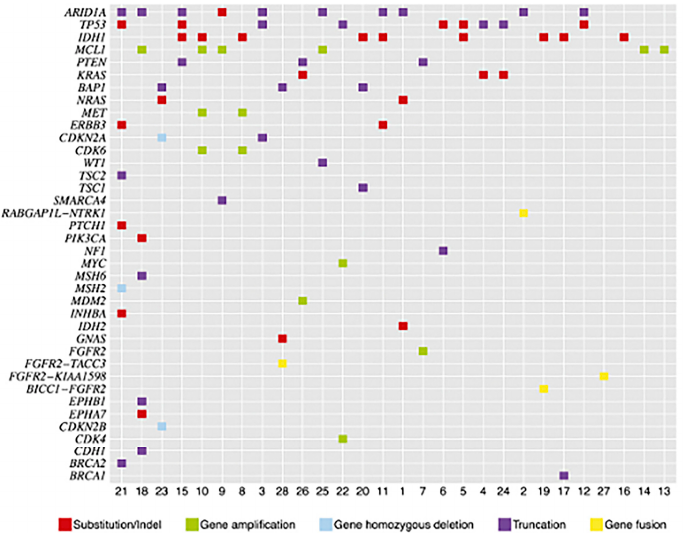
Figure 2. Tile plot of genomic alterations in 28 cases of ICC, reproduced from Ross et al. [41].